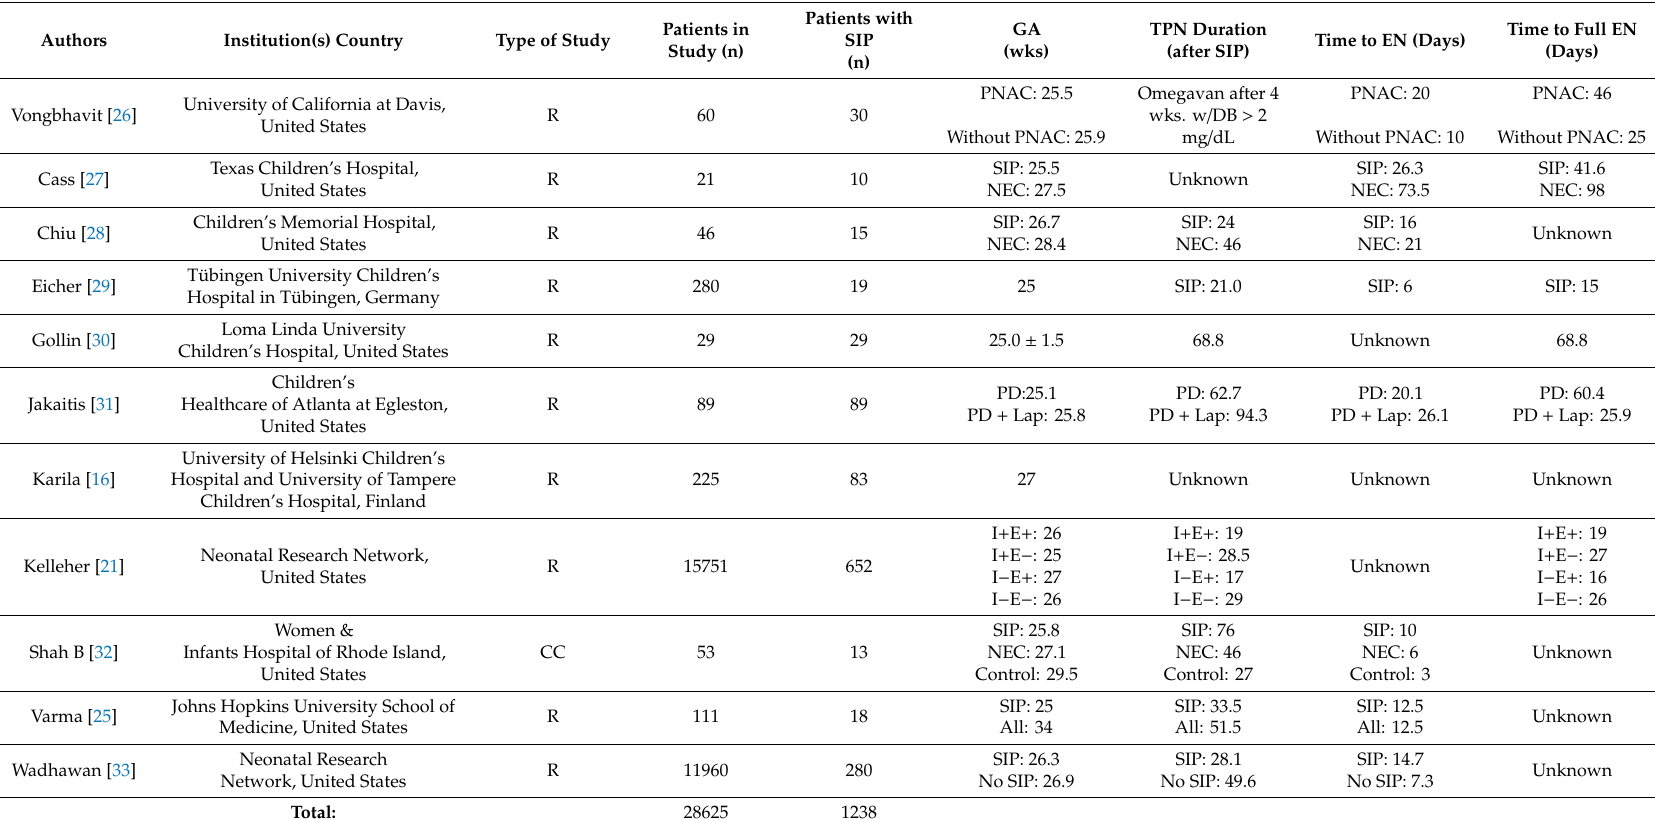
Table 3. Studies with documentation on post-operative nutrition in SIP